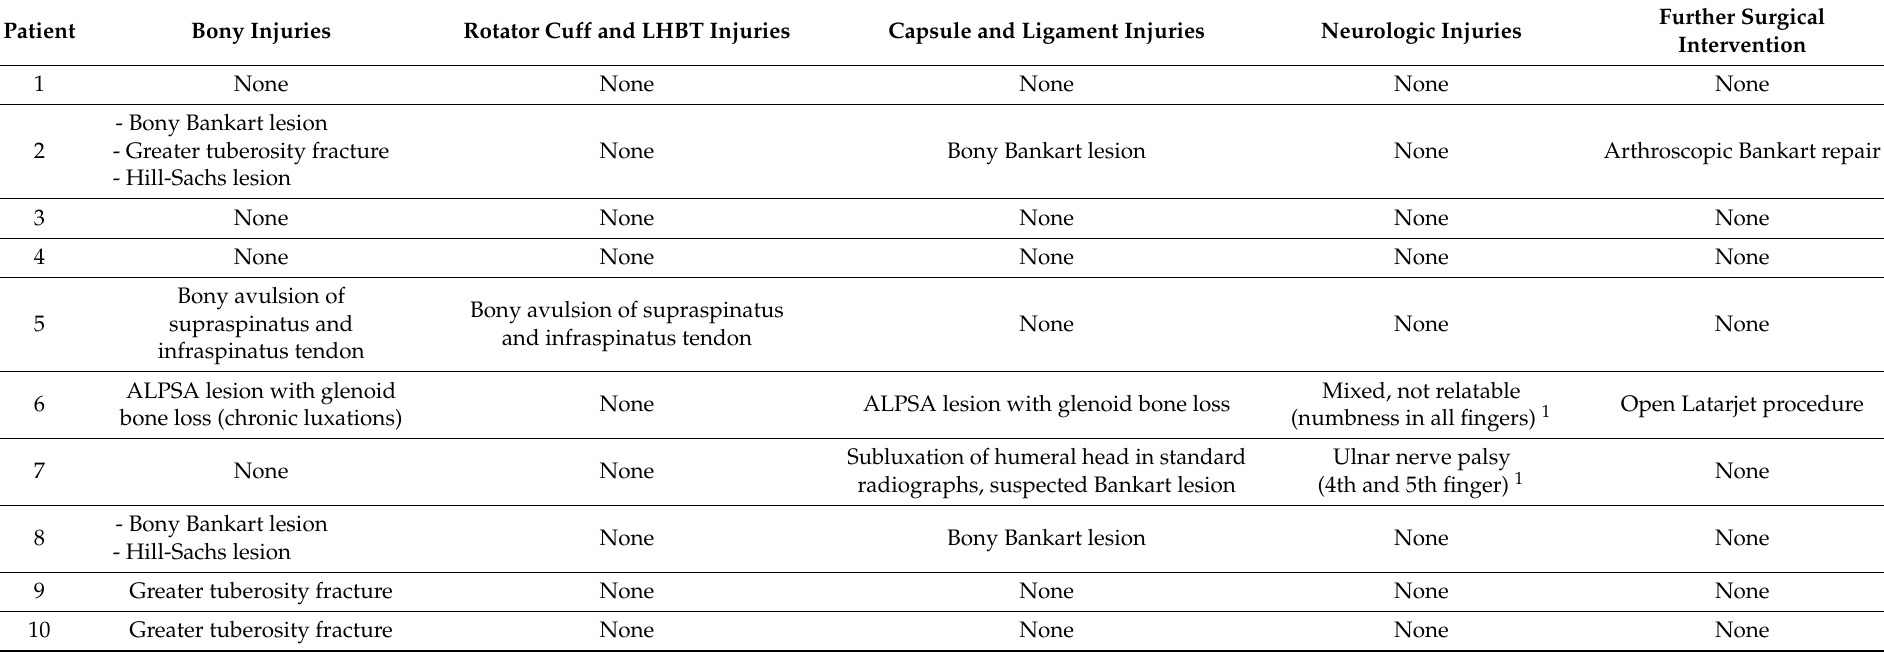
Table 2. Associated